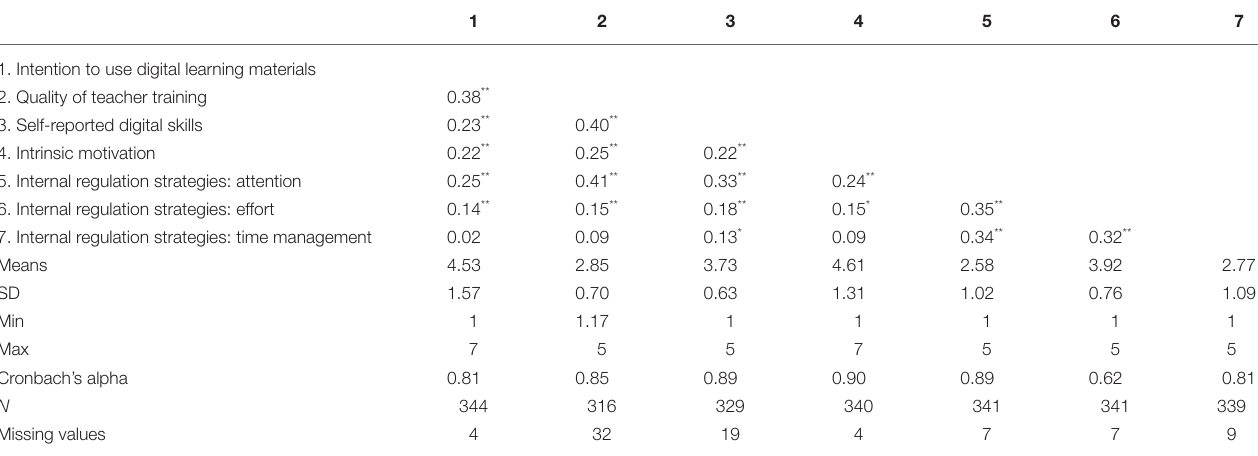
TABLE 1 | Descriptive results, correlations, and reliabilities.